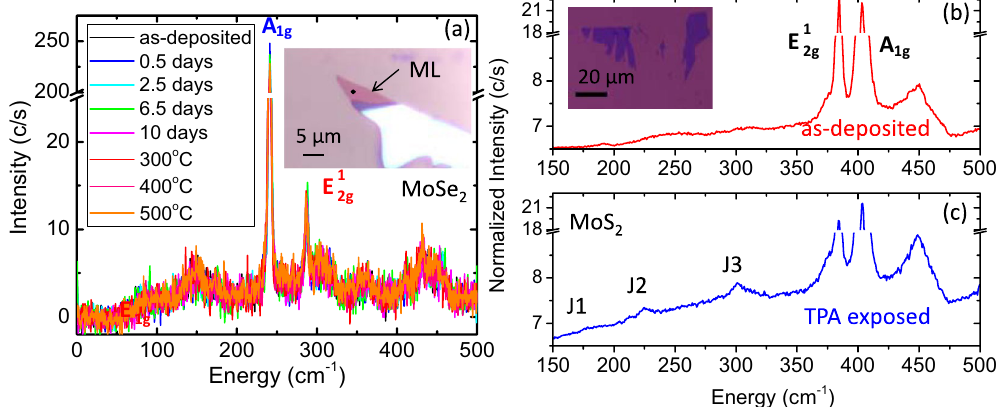
Figure 3. ( a ) Raman spectra taken on the monolayer MoSe 2 film shown in the inset after a series of exposures to TPA in a bell jar and annealing steps, in order as indicated. The black dot on the optical image in the inset indicates where the spectra were measured. The relevant peaks are labeled. No significant changes are observed. ( b ) Raman spectra are taken on the monolayer MoS 2 film shown in the optical image in the inset. This shows the spectrum from the as-deposited film. ( c ) The spectrum after 7 days exposure to TPA. The relevant peaks are labeled. Each line is an average of 10 points on the film. The appearance of the J1, J2, and J3 peaks in the exposed film is an indicator of the 1T